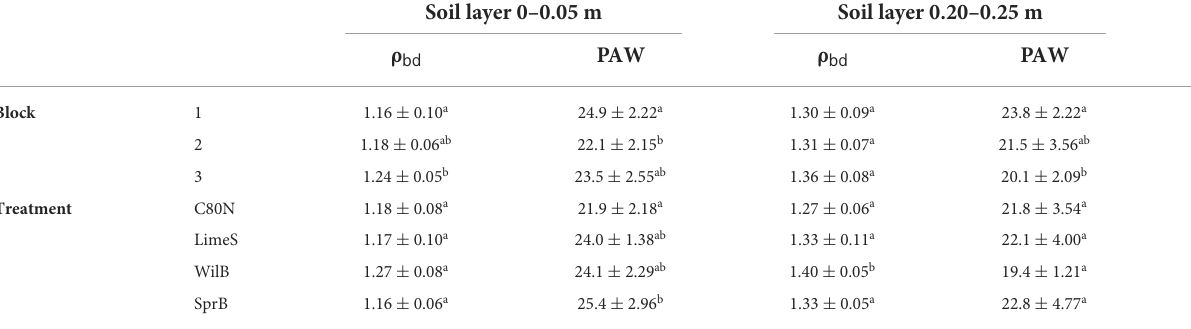
TABLE 2 Mean ( ± standard deviation) soil bulk density ( ρ bd , g cm − 3 ) and plant available water (PAW, g g − 1 ) displayed as means of the three replicate blocks ( N = 15) and treatments ( N = 9) for the amended soil layer 0–0.05m and deeper unamended soil layer 0.20–0.25m.